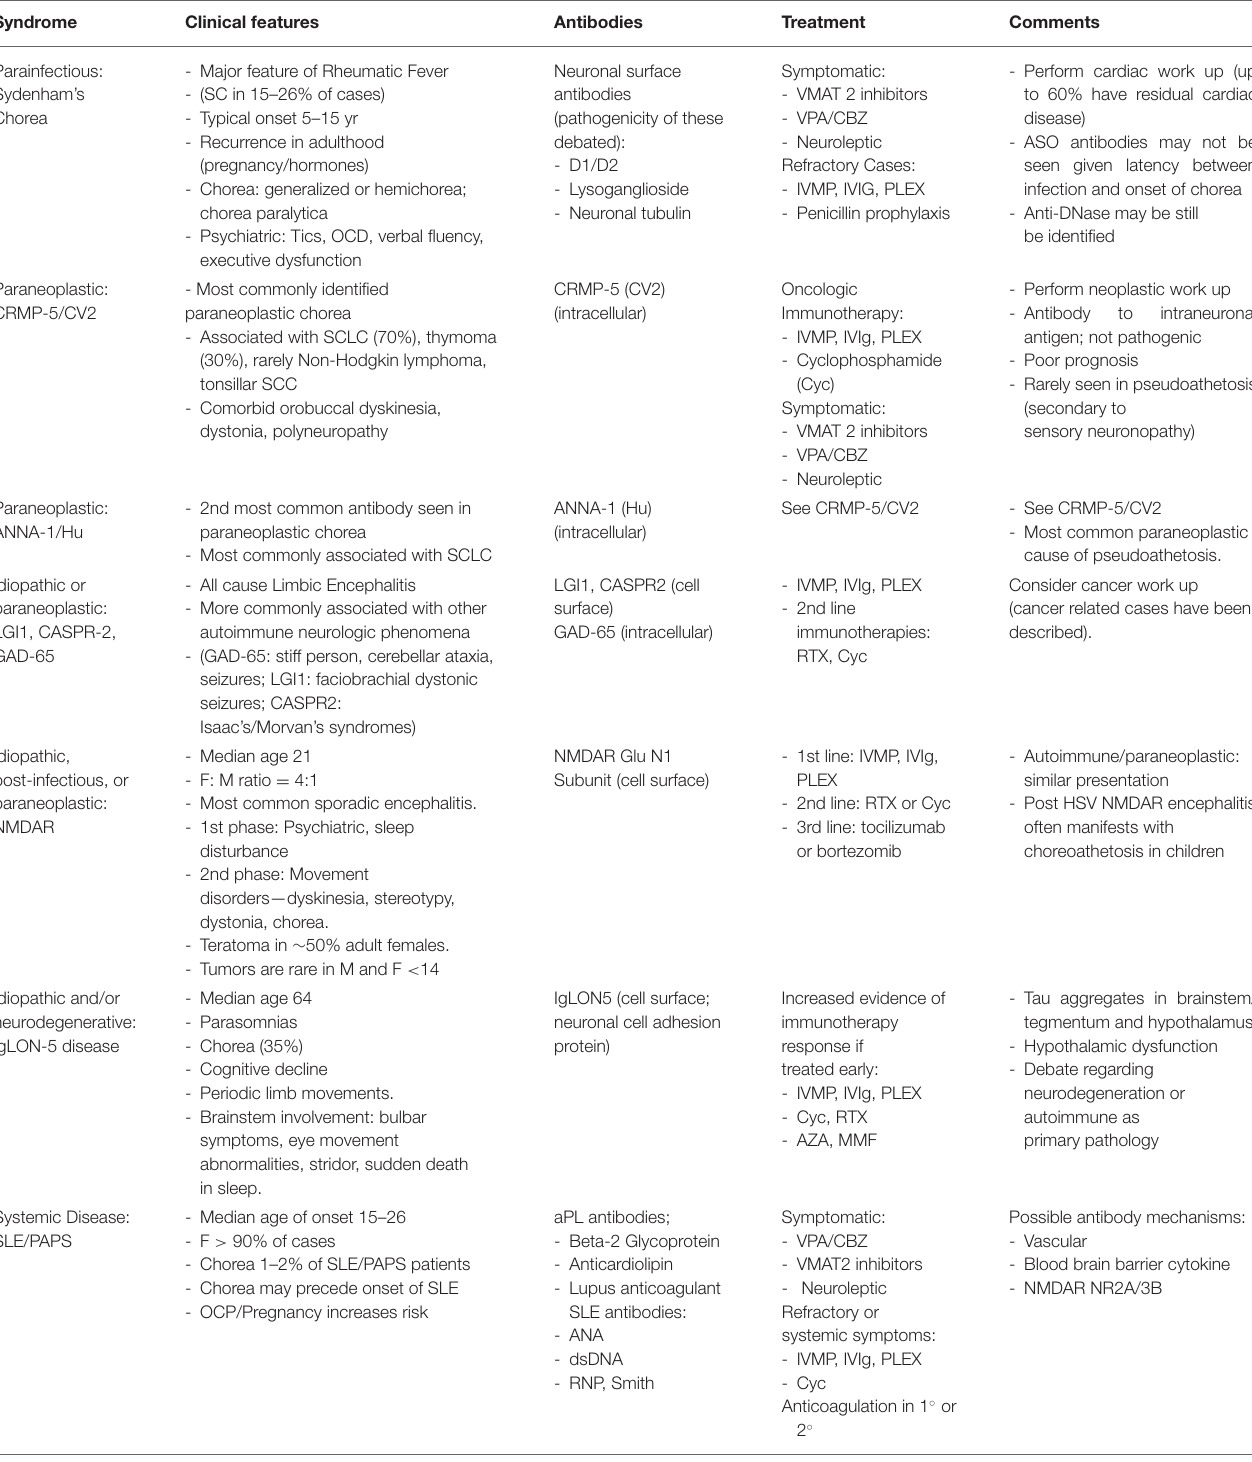
TABLE 1 | Summary of clinical syndromes and